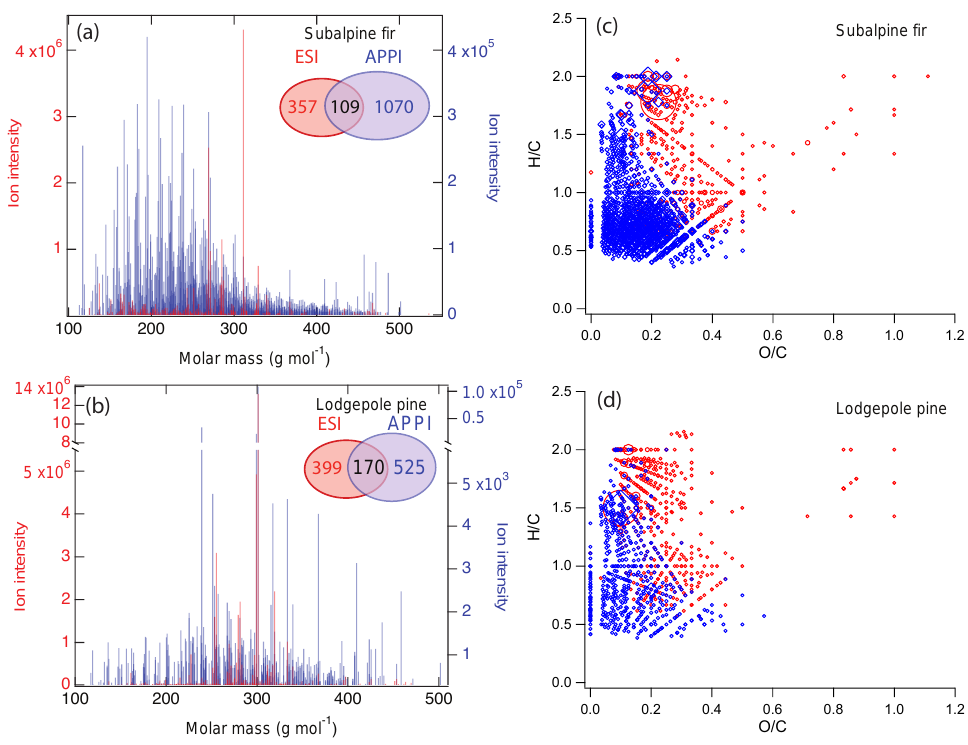
Figure 8. Mass spectra of biomass burning organic particles collected from test burns of (a) subalpine fir and (b) lodgepole pine as mea- sured by high-resolution mass spectrometry with two ionization techniques: electron spray ionization (ESI, red) and atmospheric pressure photoionization (APPI; blue). The numbers of elemental formulas identified by ESI (red), APPI (blue), and both modes (black) are also specified. Van Krevelen plots of the compounds identified by ESI (red) and APPI (blue) mode in BBOA from the burning of (c) subalpine fir and (d) lodgepole